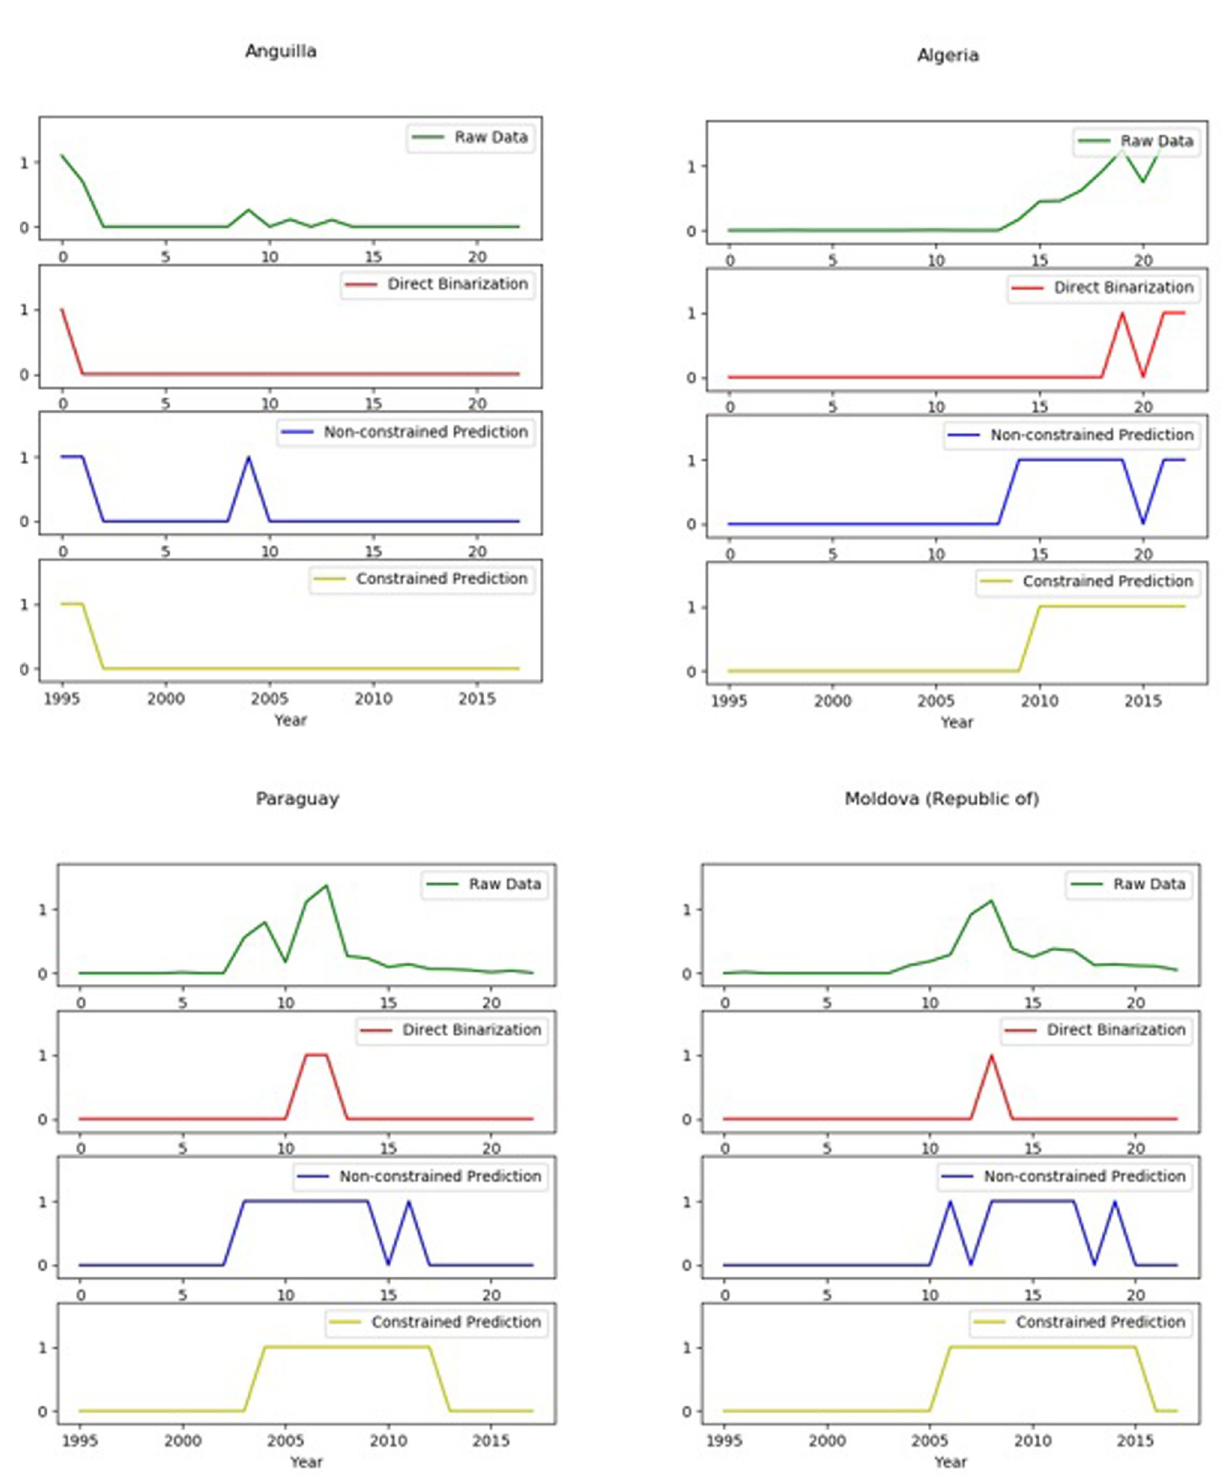
Fig 5. Country case test (A), including (1) original RCA data (2) country-product matrix binarized noise reduction data, (3) unconstrained Hidden Markov Model noise reduction data and (4) the Shortest Duration Constrained Hidden Markov model reduction data These show the abnormal data noise sanitation of SDC-HIAI. The horizontal axis is the time axis (“0” represents the starting year 1995, -20” represents 2015): and the vertical axis is the corresponding value of the sub- graph_ The original RCA data graph is the original value, and the rest of the sub-graphs are binary values.